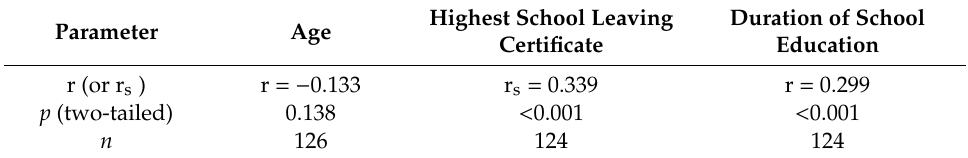
Table 4. Bivariate Pearson’s (r) or Spearman’s (r s ) correlation coe ffi cients with